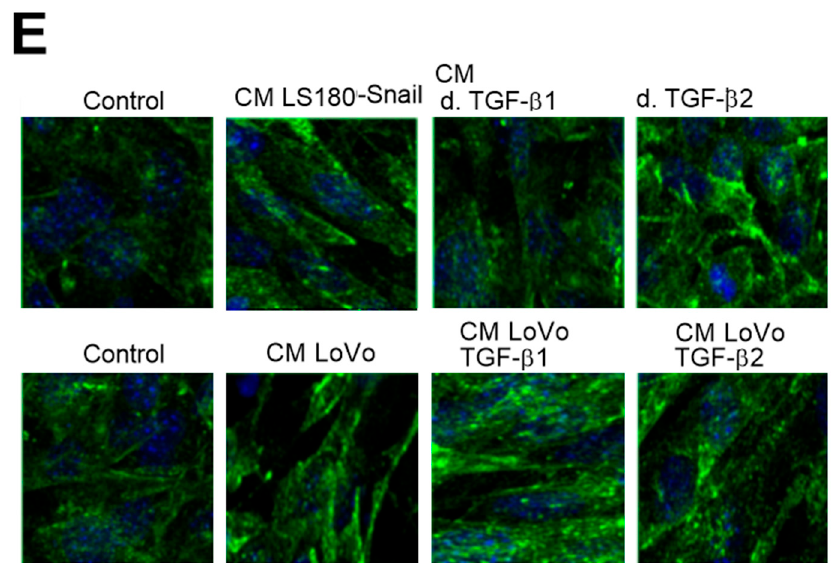
Figure 5. Phosphorylation of tubulin- β 3 in microtubules of CAF-like cells is engaged in EndMT via regulation of Rac1 activity. HMEC-1 cells were cultured in medium supplemented with conditioned medium (CM) isolated from invasive (LS180 Snail, LoVo) colon cancer cells where TGF- β 1 or TGF- β 2 was depleted (d. TGF- β 1 or d. TGF- β 2) for 216 h ( A ) or tubulin- β 3 were silenced (siRNA t. β 3) or phosphorylation of tubulin- β 3 was inhibited by wortmannin ( B ). Then, the level of Rac1 active form was determined by Western blot assay. The protein levels are normalized to GAPDH. The results are provided as means ± SD ( n = 3); ** p < 0.01, *** p < 0.005. The blots are representative of three independent experiments. t. β 3 - tubulin- β 3. Additionally, microtubule polymerization was analyzed in HMEC-1 cells cultured in medium supplemented with CM isolated from invasive (LS180 Snail, LoVo) cancer cells where TGF- β 1 or TGF- β 2 was depleted (d. TGF- β 1 or d. TGF- β 2) for 216 h ( C ) or tubulin- β 3 was silenced or phosphorylation of tubulin- β 3 was inhibited by wortmannin ( D ). Controls of microtubules polymerization with taxol and depolymerization with colchicine were conducted and are shown in the right graphs ( C , D ). Next, confocal microscopy (63 × ) of microtubules was conducted with antibodies specifically bound to tubulin- α -FITC (green) and nucleus were labelled by 4 ′ ,6-diamidino-2-phenylindole (DAPI) (blue) ( E ).